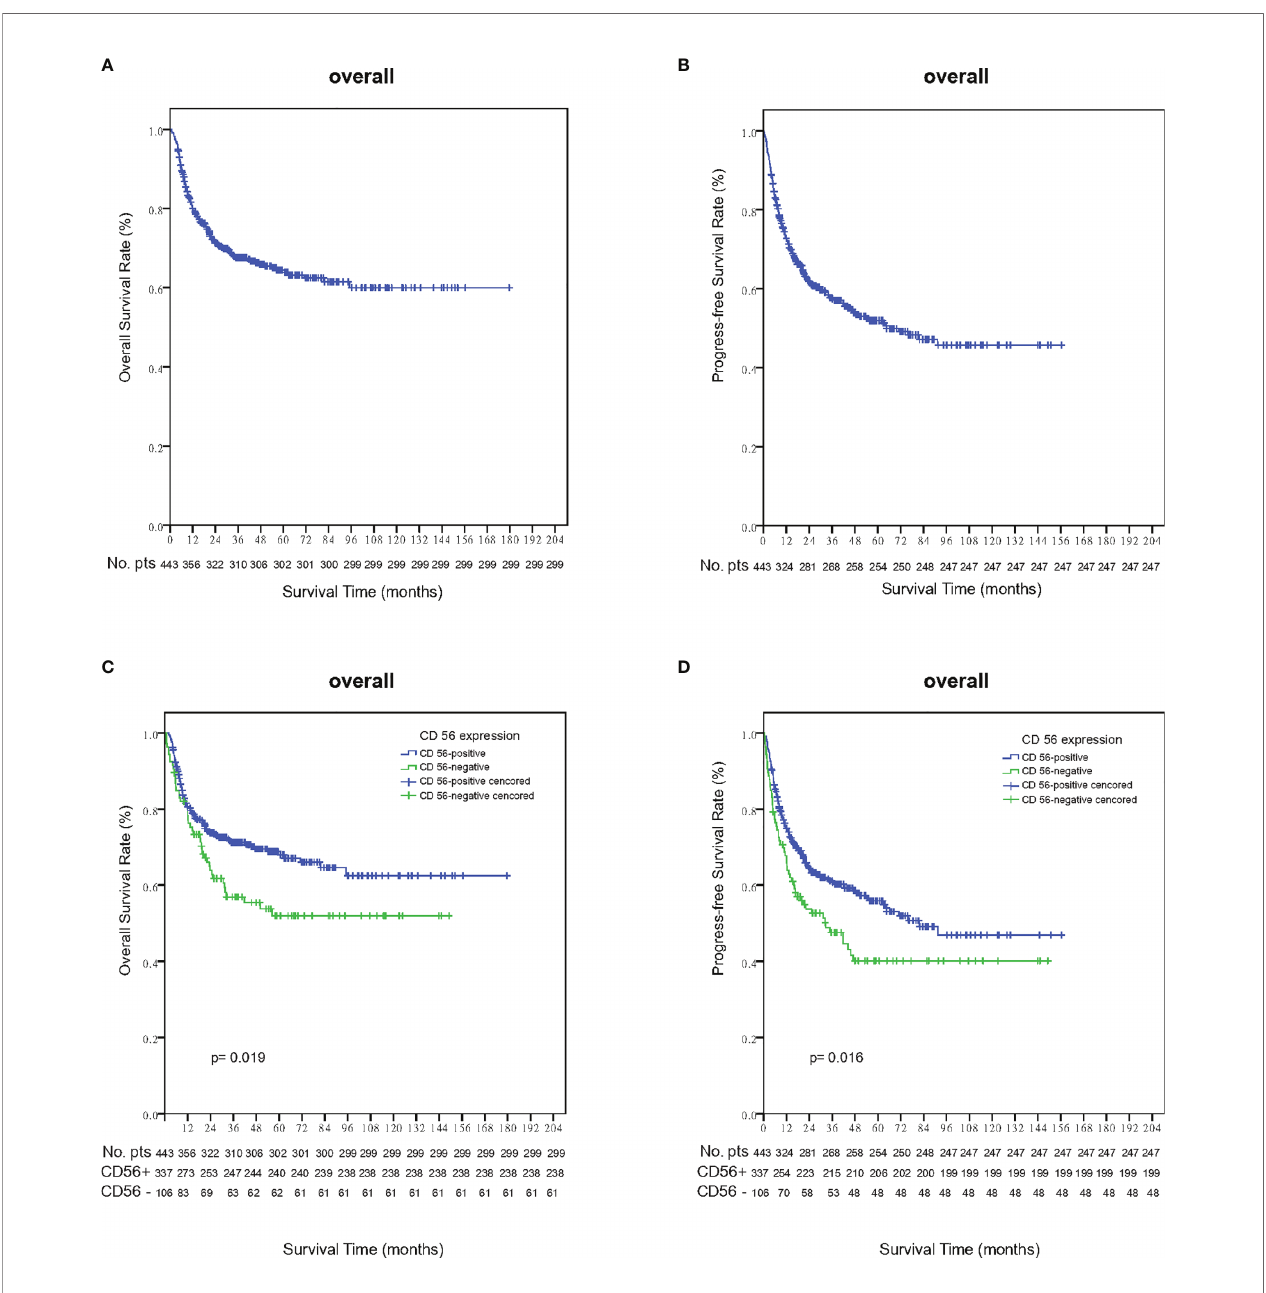
FIGURE 2 | Survival outcomes in the whole cohort of NKTCL. (A) Overall survival (OS); (B) Progression-free survival (PFS); (C) Overall survival (OS) analysis according to the expression status of CD56 in the whole cohort of NKTCL; (D) Progression-free survival (PFS) analysis according to the expression status of CD56 in the whole cohort of